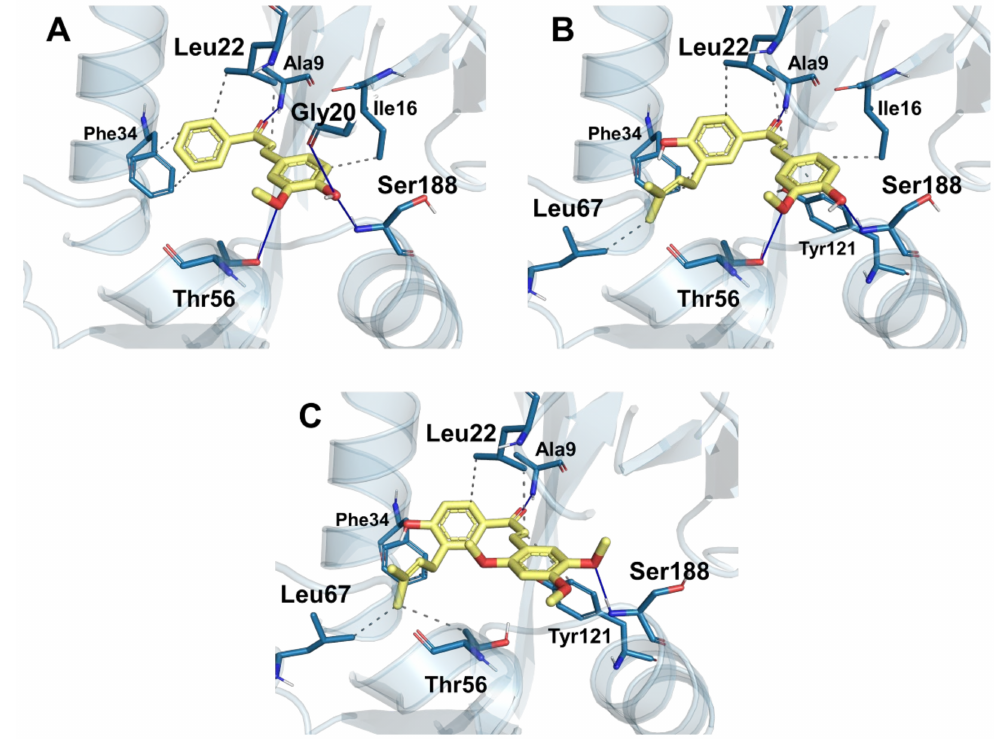
Figure 4. Interactions of the synthesized chalcones with the catalytic site of DHFR. ( A ) Binding mode of compound 6 and most residues represented. ( B ) Binding mode of compound 12 and most residues represented. ( C ) Binding mode of compound 13 and most residues